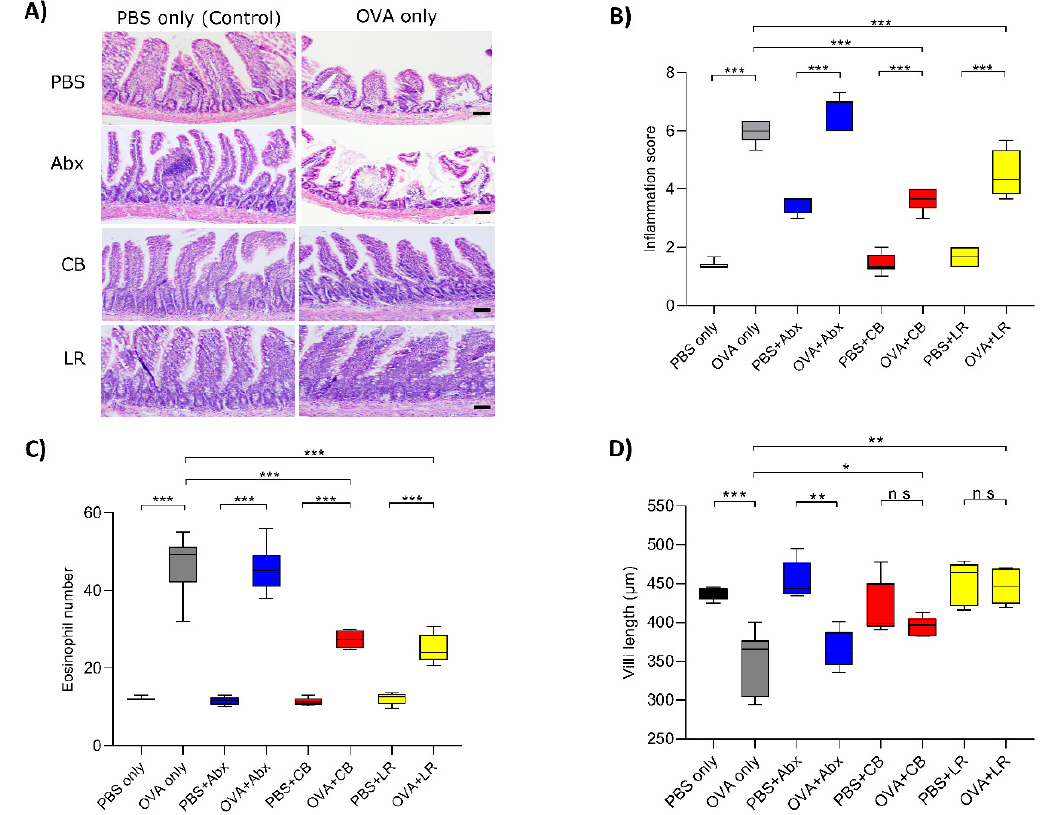
Figure 3. ( A ) Jejunal tissue sections were stained with hematoxylin and eosin for histological examination. Although the jejunal villi were damaged in the OVA-sensitized group and those in